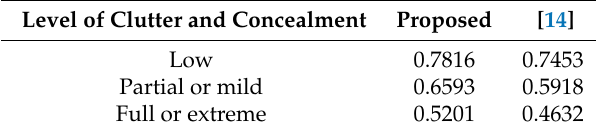
Table 6. Quantitative evaluation of the proposed framework and other state-of-the-art frameworks on SIXray [14] dataset towards detecting contraband items exhibiting different level of clutter and